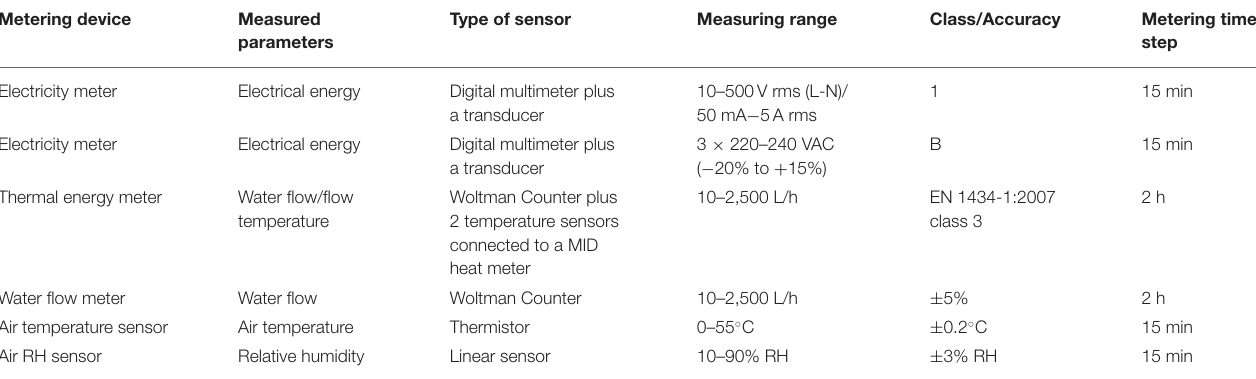
TABLE 1 | Technical features of main installed metering devices or